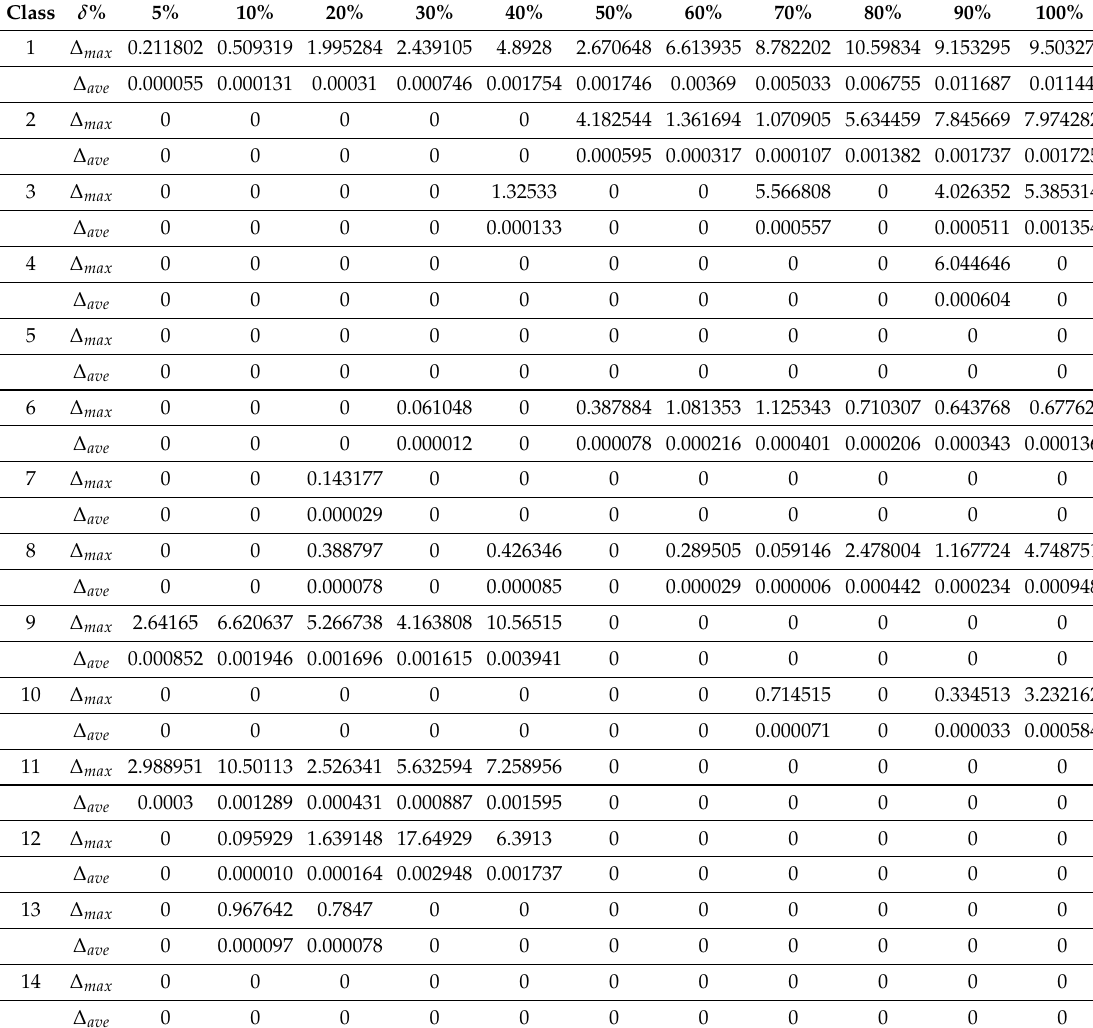
Table 5. Maximal errors ∆ max and average errors ∆ ave for all tested instances with factual processing times randomly generated based on a gamma